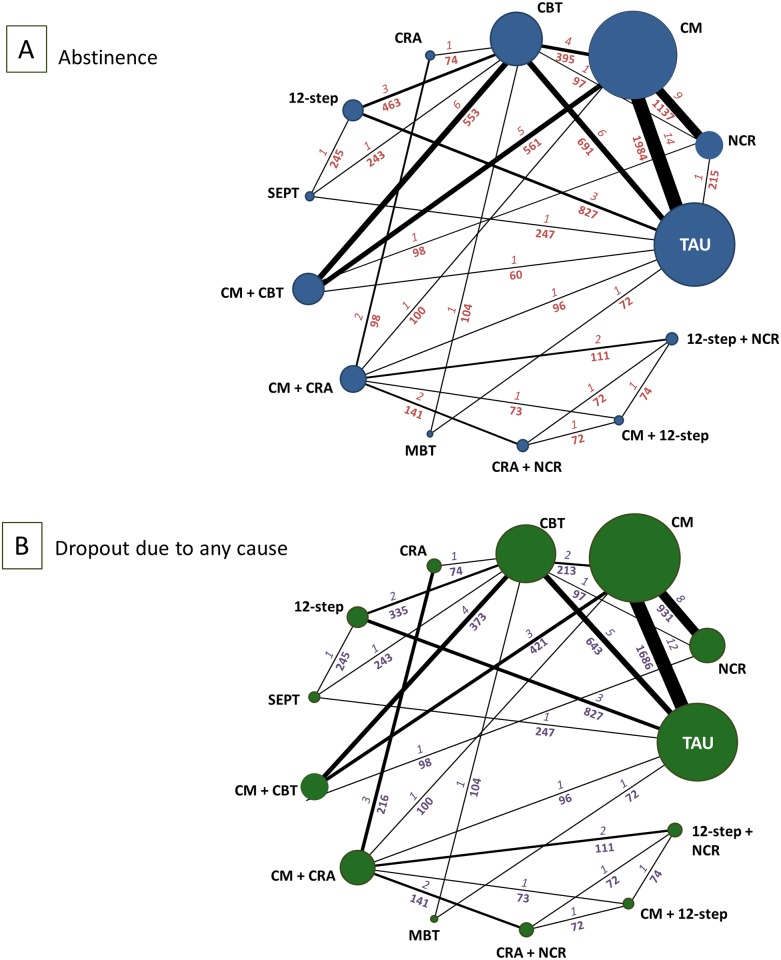
Network of eligible comparisons for abstinence and dropout due to any cause at the end of treatment.The figure plots the network of eligible direct comparisons for abstinence at the end of treatment (46 trials) (A) and dropout due to any cause (43 studies) (B). The width of the lines is proportional to the number of trials comparing every pair of treatments, and the size of every node is proportional to the number of randomised participants. The numbers above each connection relate to the numbers of trials and the numbers below each connection relate to the number of patients for each direct comparison. 12-step, 12-step programme; CBT, cognitive behavioural therapy; CM, contingency management; CRA, community reinforcement approach; MBT, meditation-based treatments; NCR, non-contingent rewards; SEPT, supportive-expressive psychodynamic therapy; TAU, treatment as usual.